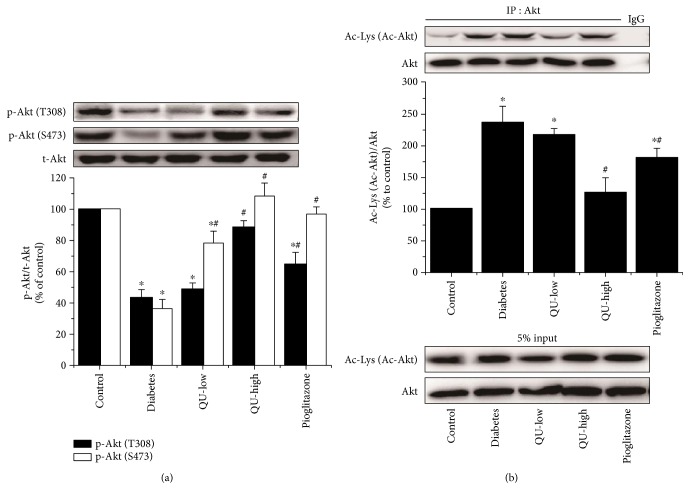
Effects of quercetin on Akt. The effects of quercetin on (a) Akt phosphorylation levels and (b) Akt deacetylation levels in the livers of control, diabetes, QU-low, QU-high, and pioglitazone-treated rats were determined through immunoprecipitation and Western blot. Data are means ± SD, n = 8. ∗P < 0.05 versus control group and #P < 0.05 versus diabetic group by ANOVA.